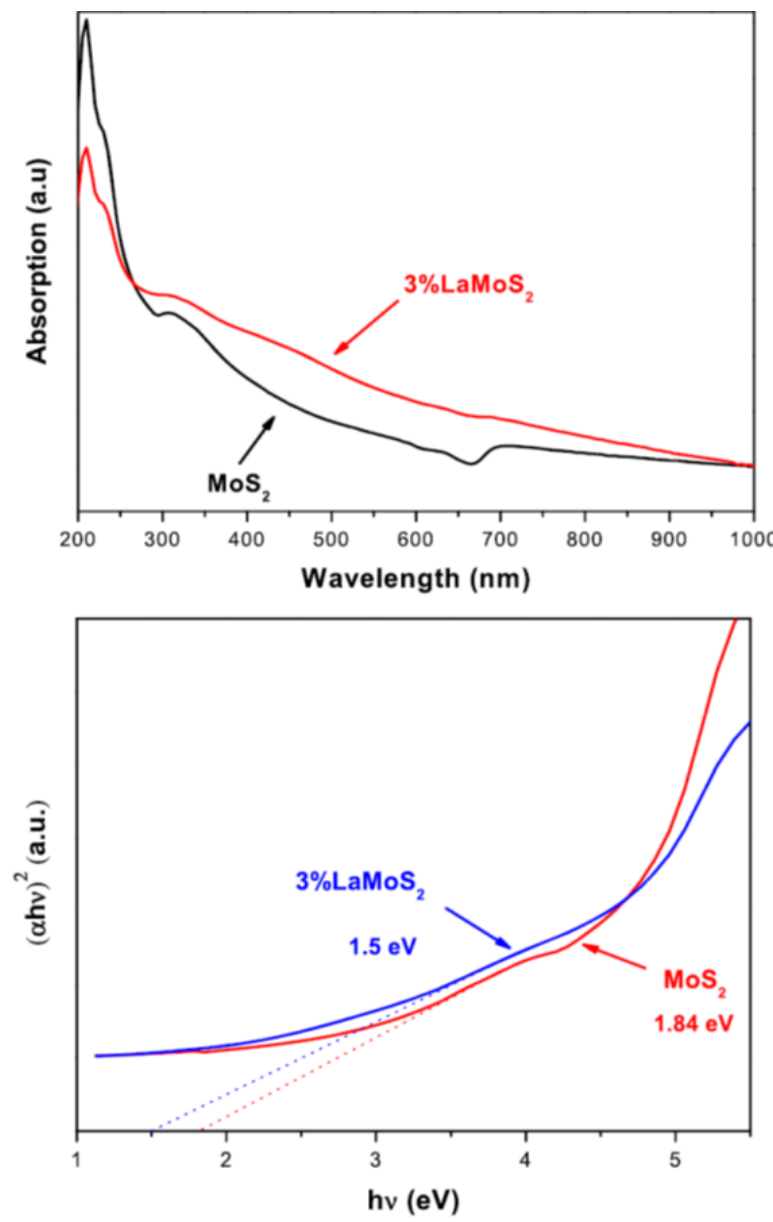
Figure 25. UV–Visible absorption spectra of 3-D flower-like MoS 2 and 3% LaMoS 2 nanoflake samples. Reproduced with permission from